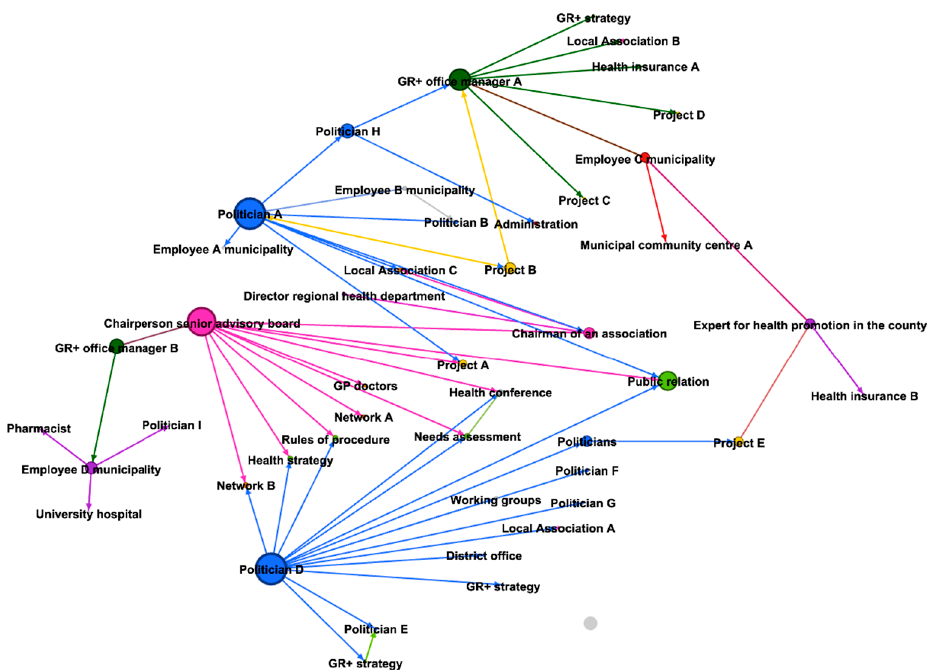
Figure 3. Map from the perspective of the steering committee members. The size of the nodes displays the betweenness centrality of the actors. Blue nodes indicate politicians, yellow nodes indicate projects, pink nodes indicate associations, brown nodes indicate external contacts, purple nodes indicate actors from the public health service, red nodes indicate members of the public administration, nodes in darker green are the members of the project management office of the Healthy Region Plus, the nodes in a lighter green indicate events of the strategy of the Healthy Region Plus and the grey nodes are others.